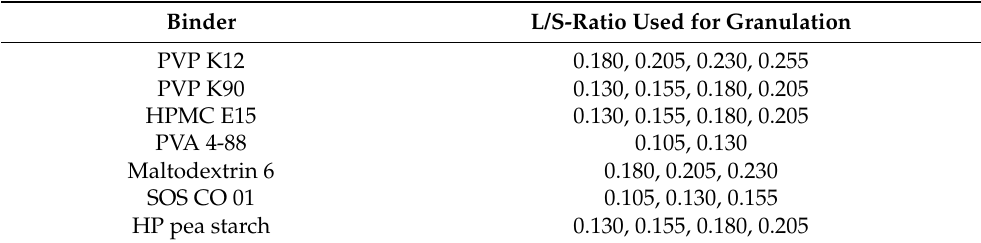
Table 1. L/S-ratios used for granulation experiments of poorly-soluble filler (DCP) illustrated with different binders